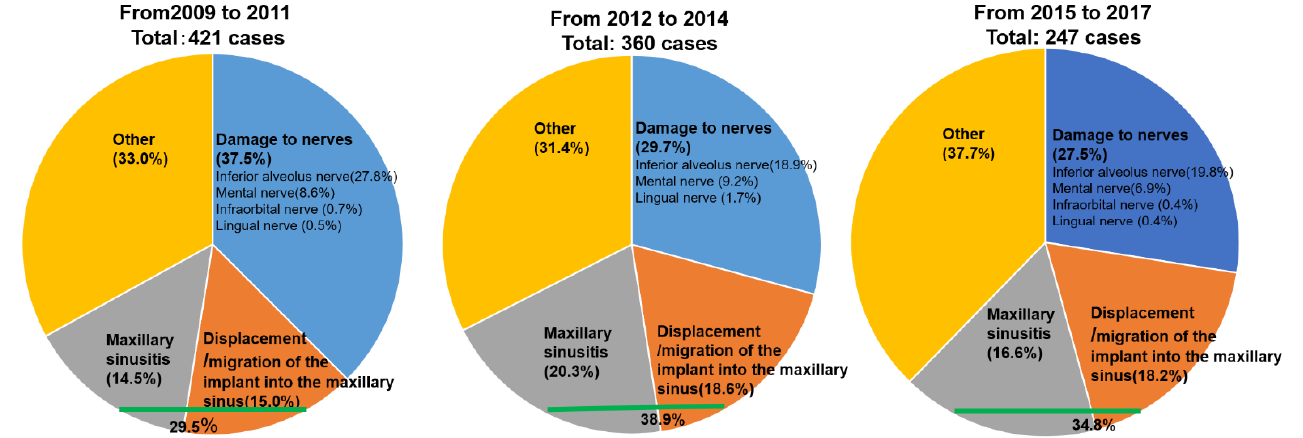
Figure 1. Before 2012, the rate of damage to nerves (37.5%) was higher than that of MSRCs (29.5%) (both maxillary sinusitis and displacement or migration of the implant into the maxillary sinus). In contrast, since 2012, the rate of MSRCs has been higher than that of damage to nerves due to complications after implant surgery in Japan. Adapted from References [5–7].